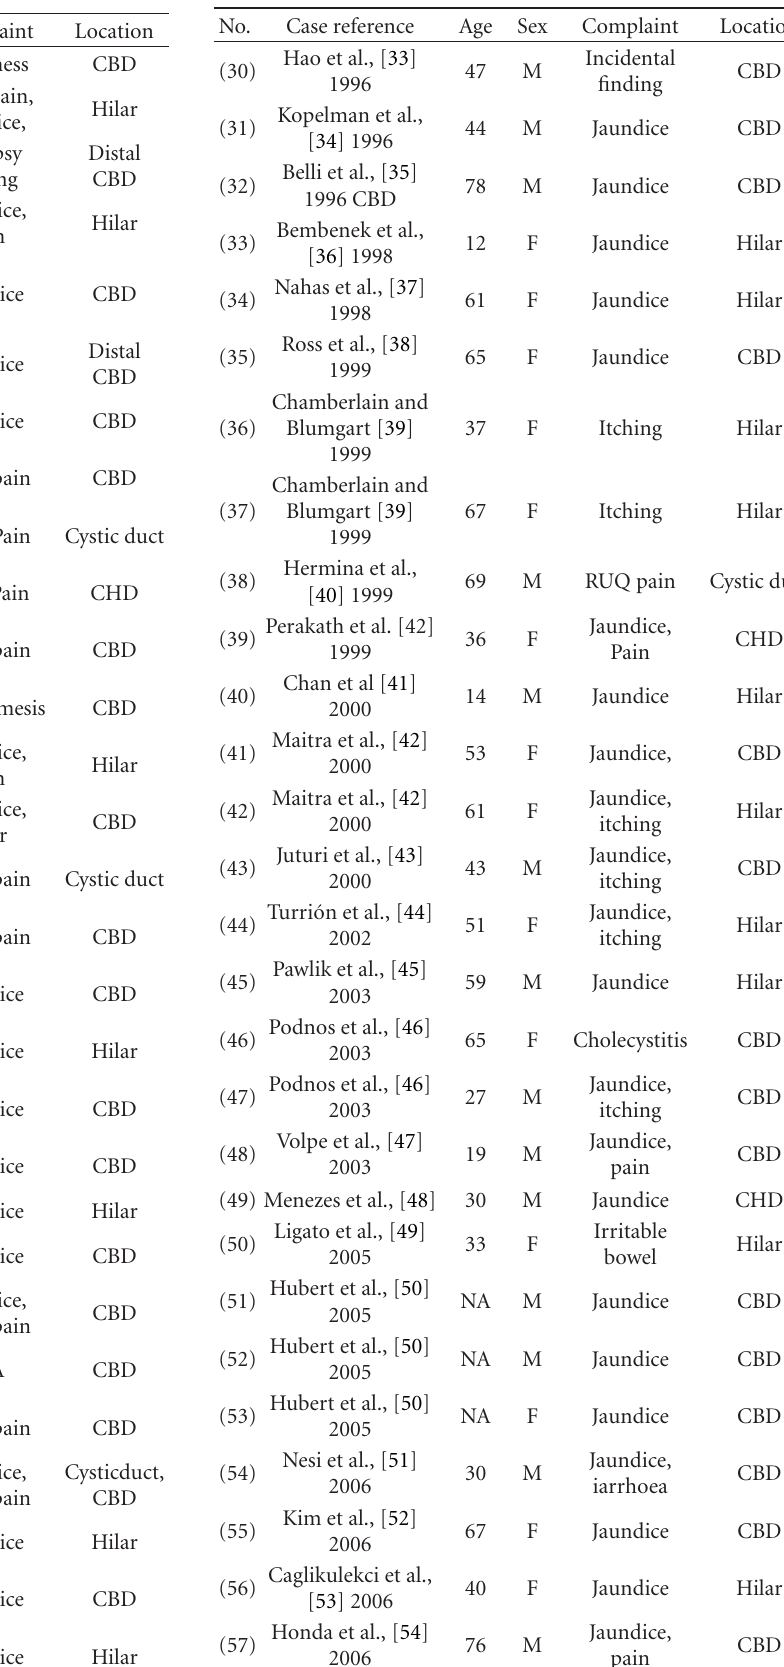
Table 1: Showing study of reported cases of Biliary tract